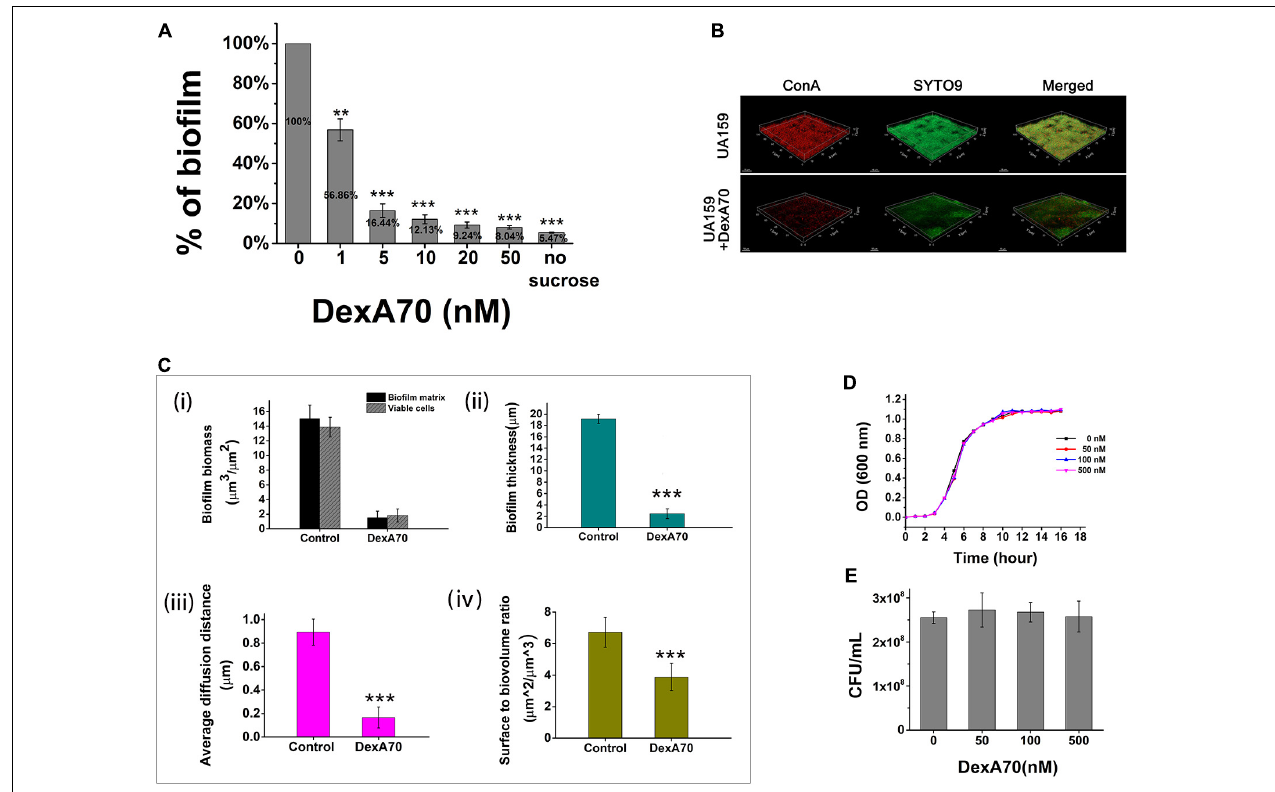
FIGURE 3 | DexA70 inhibits biofilm formation without affecting bacterial growth. (A) DexA70 inhibited UA159 biofilm formation in a dose-dependent manner. Inhibition effect was calculated by the ratio of remaining biofilm biomass post DexA70 treatment to that of untreated control. (B) Exogenous DexA70 efficiently prevented the biofilm formation by UA159. Images were 1-day-old biofilm grown with/without DexA70 and corresponding CLSM z-stack images (dextran in red stained by ConA and viable cells in green stained by SYTO9). 63 × oil immersion magnification, scale bar = 15 µ m. (C) Morphological parameters were evaluated by processing CLSM stack images of biofilms, cultivated with/without DexA70. (i). Biofilm biomass and viable cell biomass. (ii). biofilm thickness. (iii). Average diffusion distance of biofilm. (iv). Surface to biovolume ratio of biofilm. Data were calculated from three independent measurements and were reported as average. (D,E) The planktonic growth curve (D) and the colony-forming unit enumeration (E) of UA159 in BHI media with various concentrations of DexA70. The exogenous DexA70 does not affect cell growth. Statistical significance is indicated as compared with negative control using a t -test. ** p < 0.01; *** p <